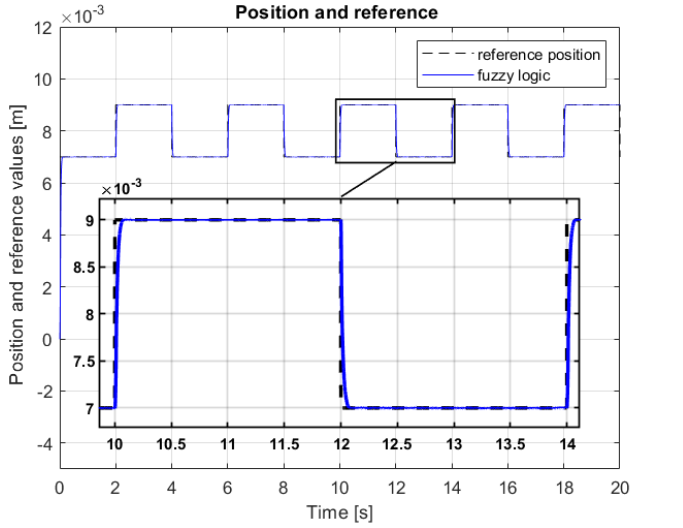
Figure 8. The system response—the hybrid PID controller